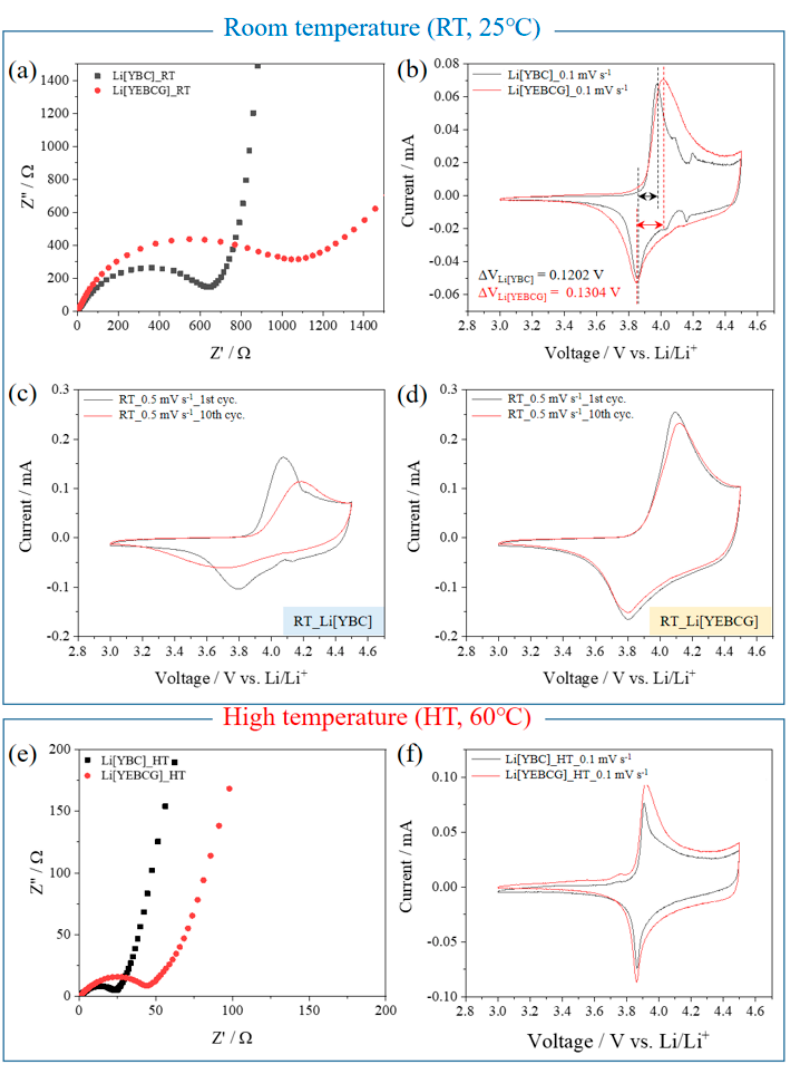
Figure 7. Nyquist plots and CV curves of Li[YBC] and Li[YEBCG] under various experimental conditions. ( a , e ) EIS data before the CV tests at equilibrium states, ( b , f ) initial CV curves at 0.1 mV s − 1 , and ( c , d ) CV curves during the 1st and 10th cycles at 0.5 mV s − 1 , where ( a – d ) were tested at 25 °C and ( e , f ) at 60 °C.